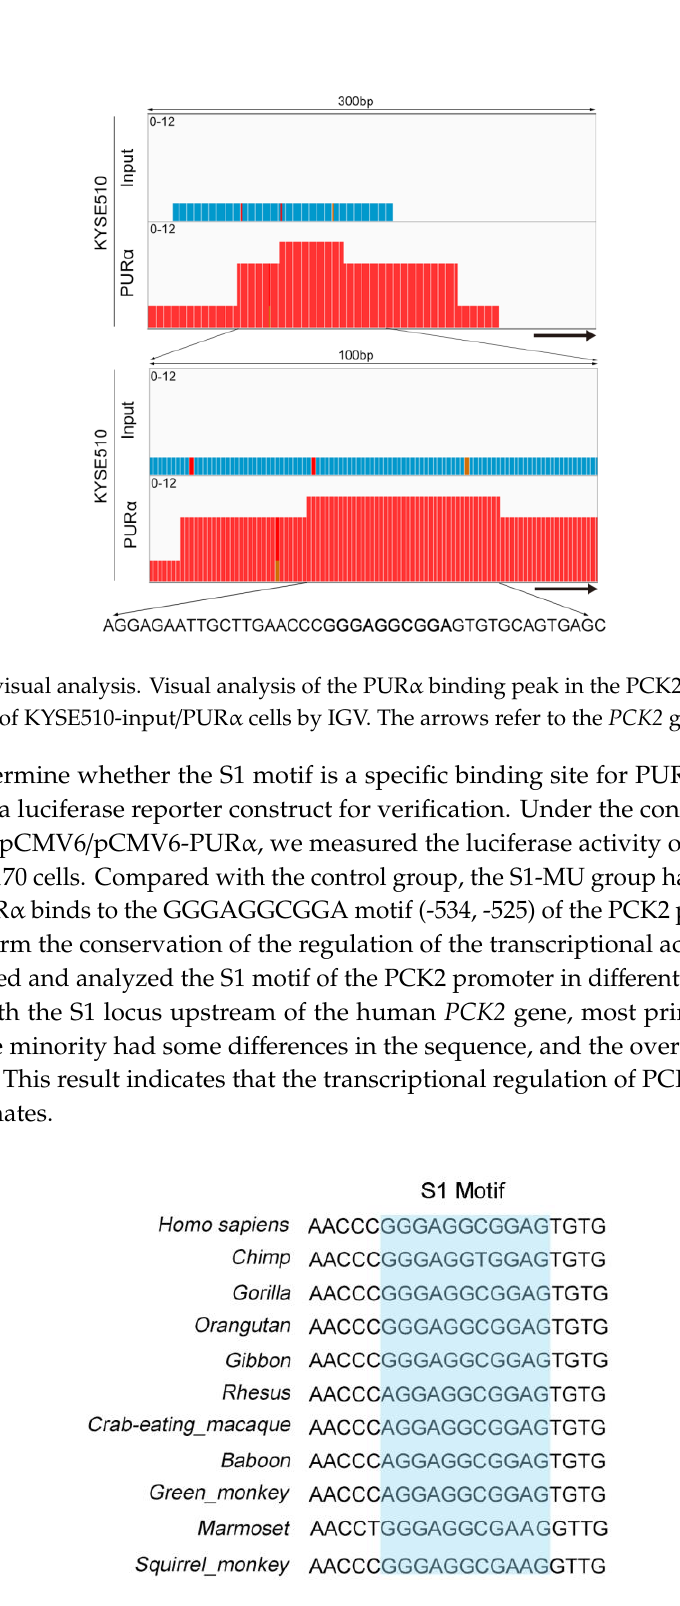
Figure 6. Sequence analysis of the S1 motif in the PCK2 promoter region of different